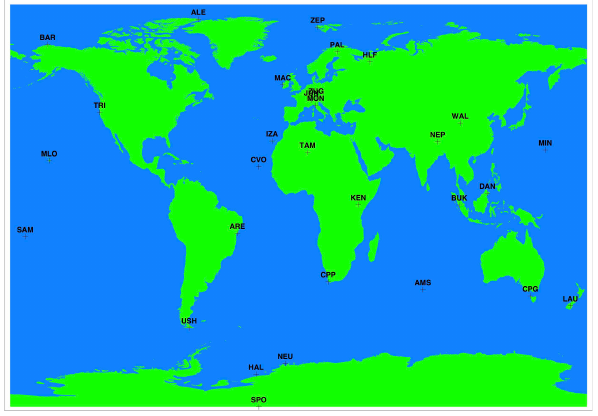
Fig. 7. Locations of the WMO GAW Global observatories.